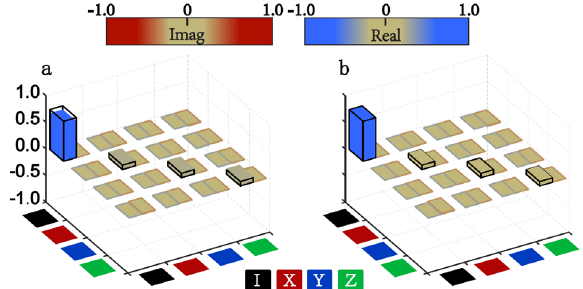
Fig. 3 Process tomography. a Measured process matrix associated with the output state of Q 2 . b Measured process matrix associated with Q 3 ’ s output state. The black wire frames denote the corresponding process matrix elements of the perfect